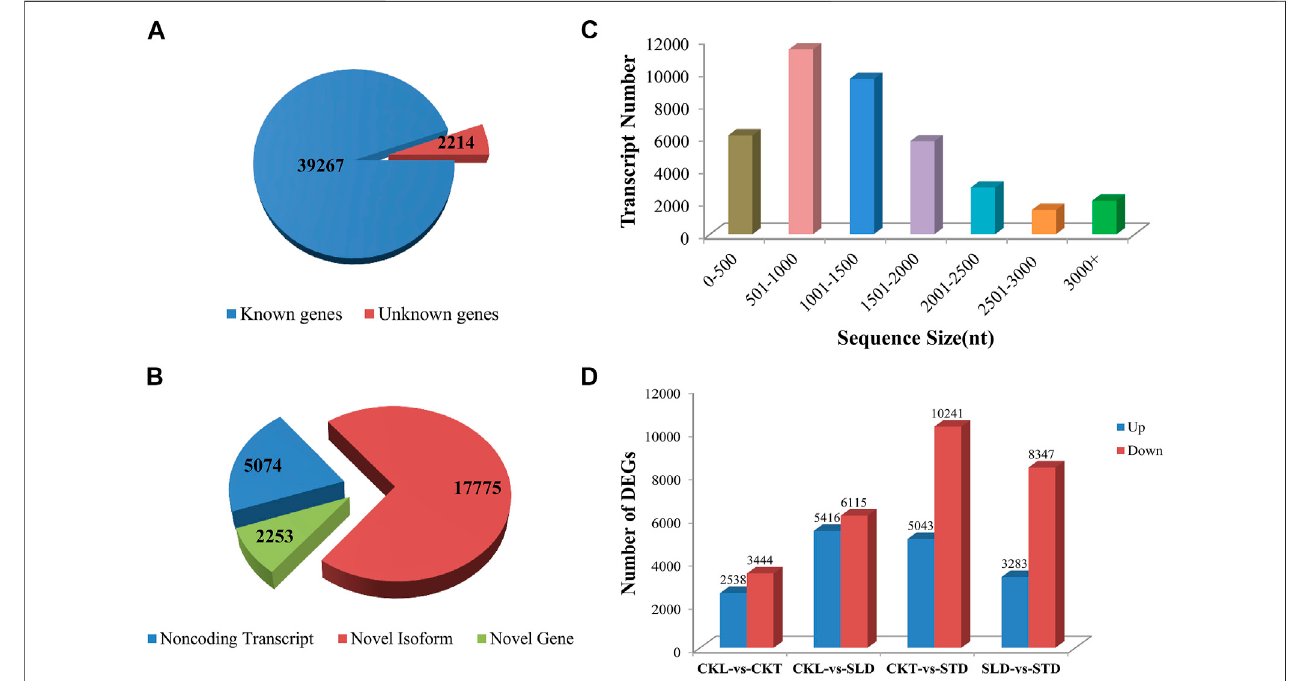
FIGURE 2 | Overview of transcriptome data in B. rapa under freezing treatments. (A) The total number of detected expressed genes. (B) The number of new transcripts detected. (C) The length of the detected transcripts. (D) The number of DEGs in CKL vs . CKT, CKL vs . SLD, CKT vs . STD, and SLD vs . STD.